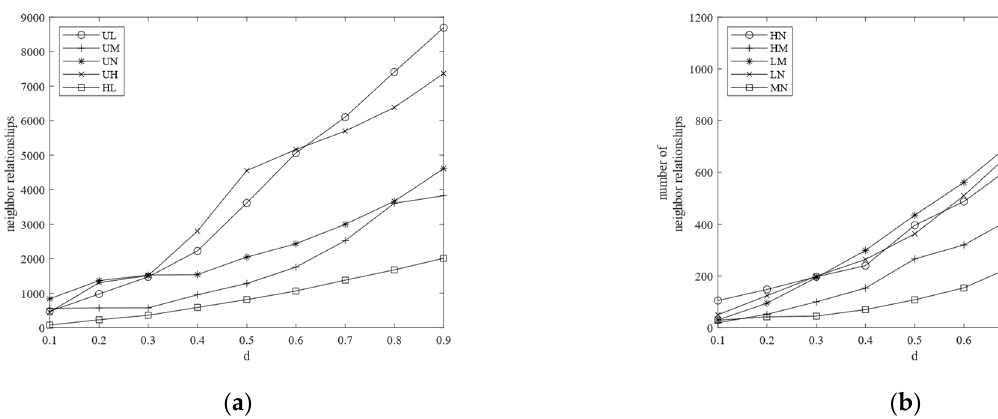
Figure 8. ( a ) The number of neighbor relationships of { U , L } , { U , M } , { U , N } , { U , H } and { H , L } ; ( b ) the number of neighbor relationships of { H , N } , { H , M } , { L , M } , { L , N } and { M , N } Effect of 𝒎𝒊𝒏 _ 𝒅 on participation ratio and participation index